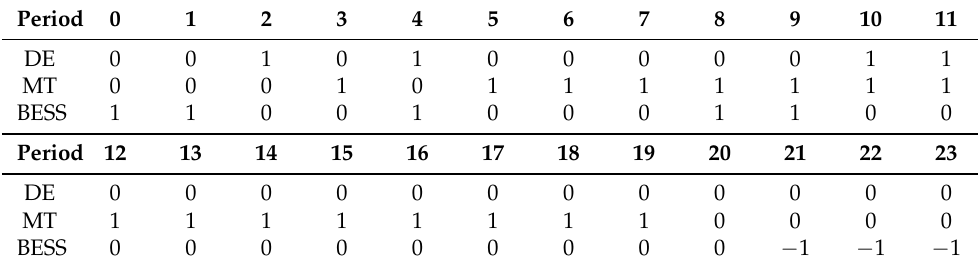
Table 6. The on–off status of the units each time period of the day using the MIP algorithm. Period 0 1 2 3 4 DE 0 0 1 0 1 0 0 0 0 0 1 1 MT 0 0 0 1 0 BESS 1 1 0 0 0 0